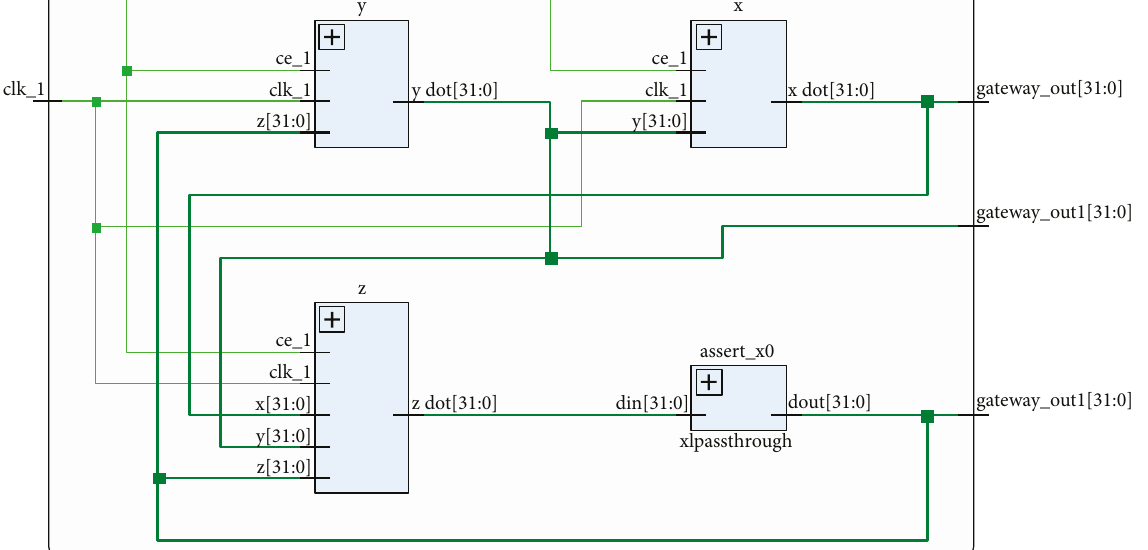
Figure 7: Overall RTL schematics of (3).